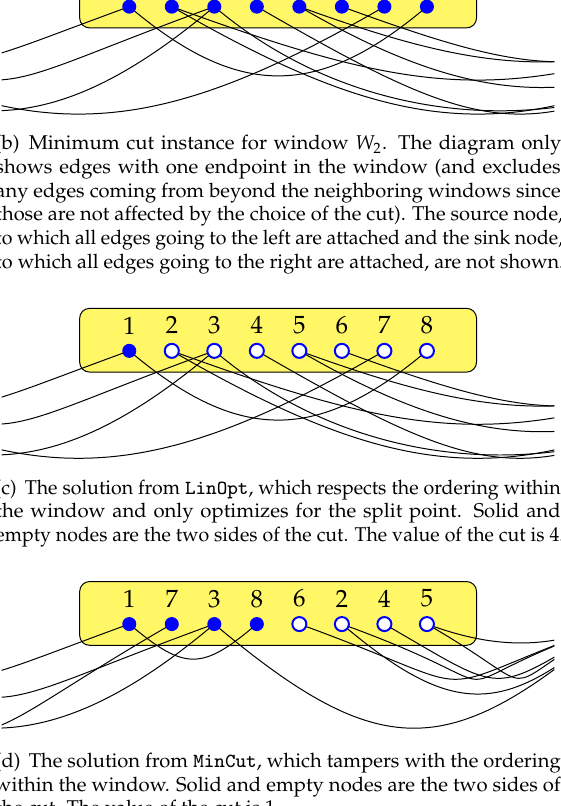
Figure 3. Illustration of MinCut